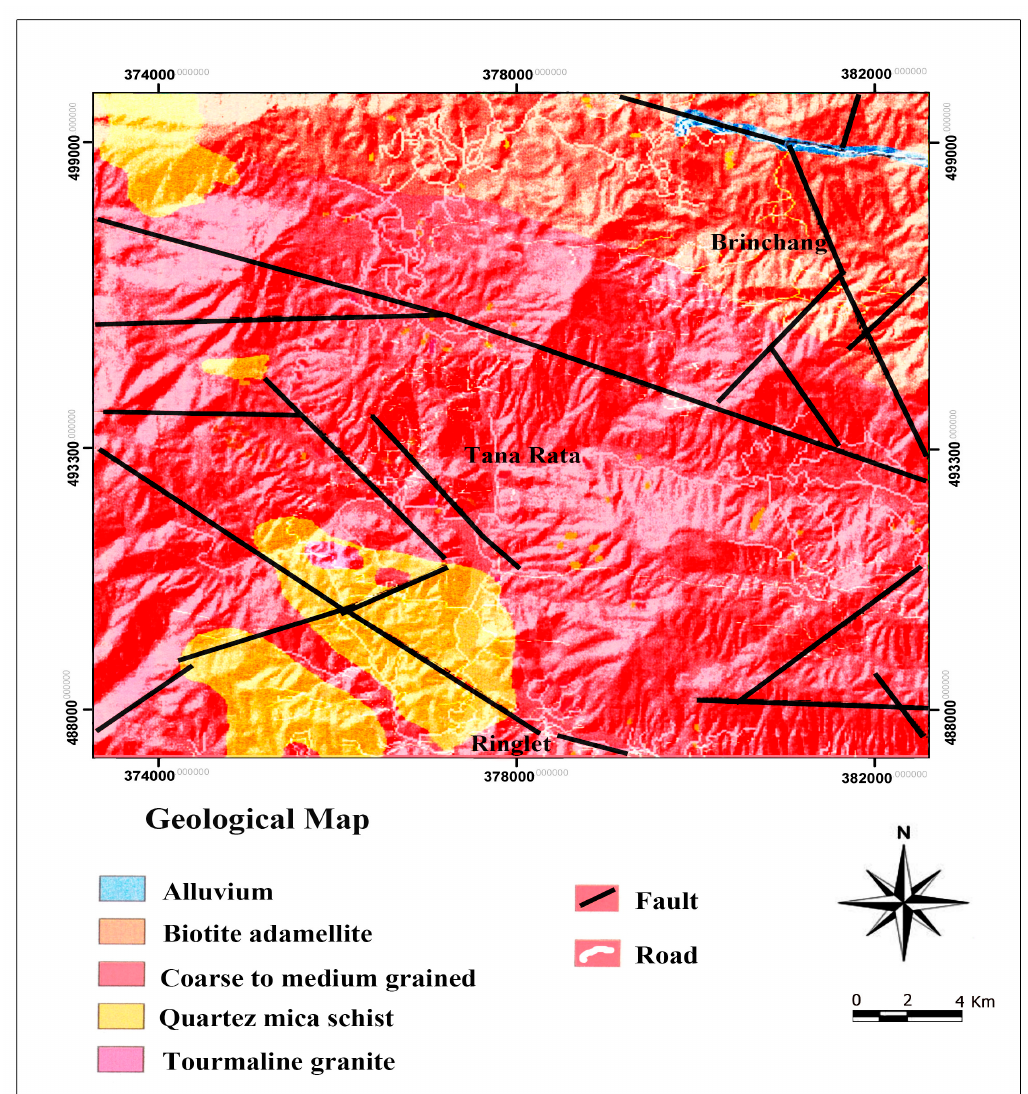
Figure 2. The geological map of a part of the region of the Cameron Highlands as the study area.